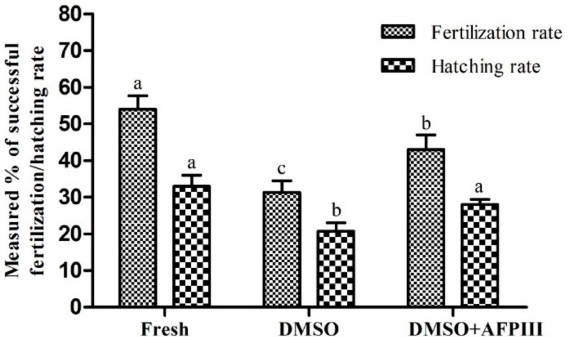
Figure 8. Fertility and hatchability of Pacific abalone sperm cryopreserved using 8% DMSO alone or 8% DMSO in combination with 10 µ g/mL AFPIII. Significantly different levels ( p < 0.05) are denoted by different